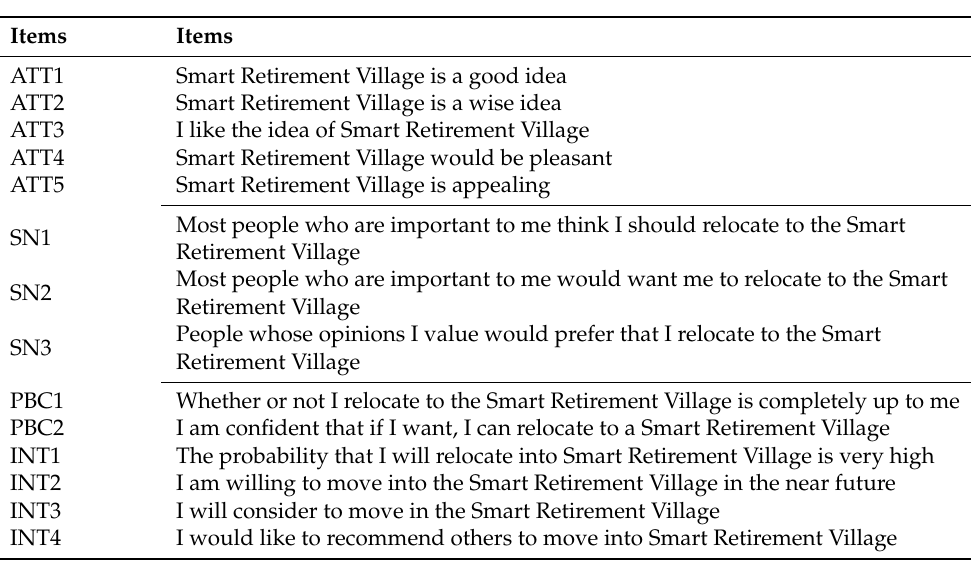
Table A2. Survey Instrument on the Variables of Attitude (ATT), Subjective Norm (SN), Perceived Behavioral Control (PBC), and Intention